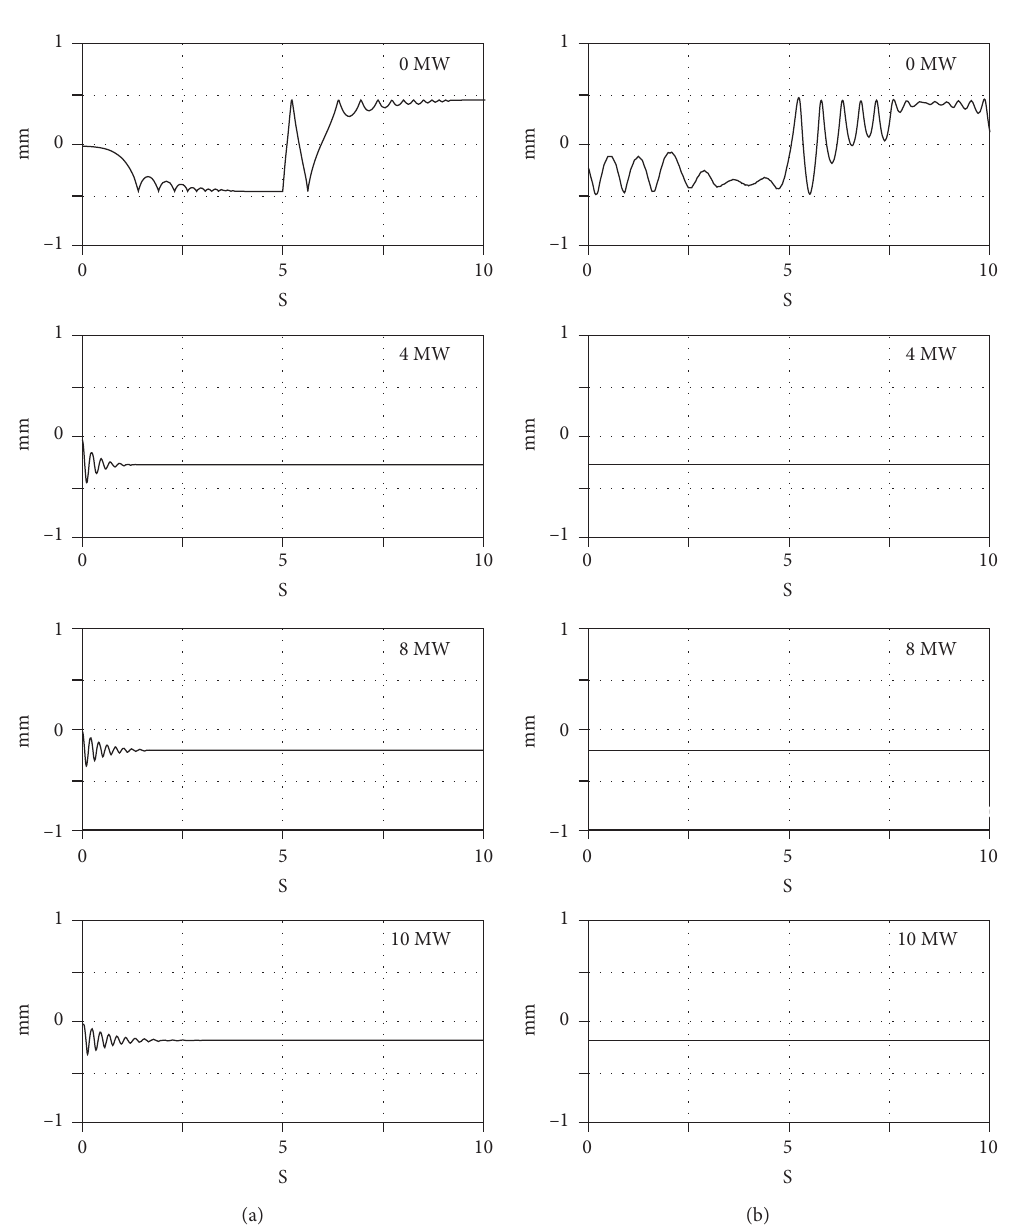
Figure 19: Simulated and measured waveform, Case I. (a) Simulation. (b) Experimental. Table 3: Model prediction and experimental measurements, Case